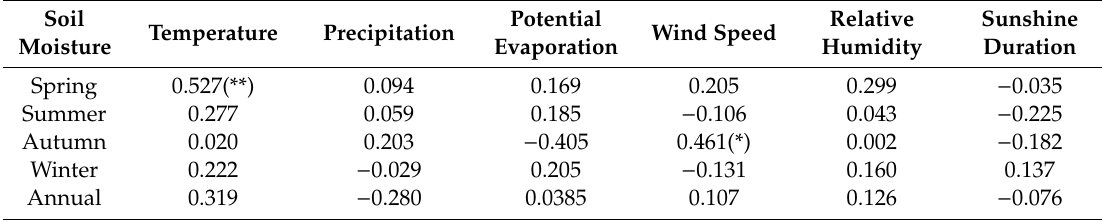
Table 3. Correlation analysis between the relative soil moisture of farmland and meteorological